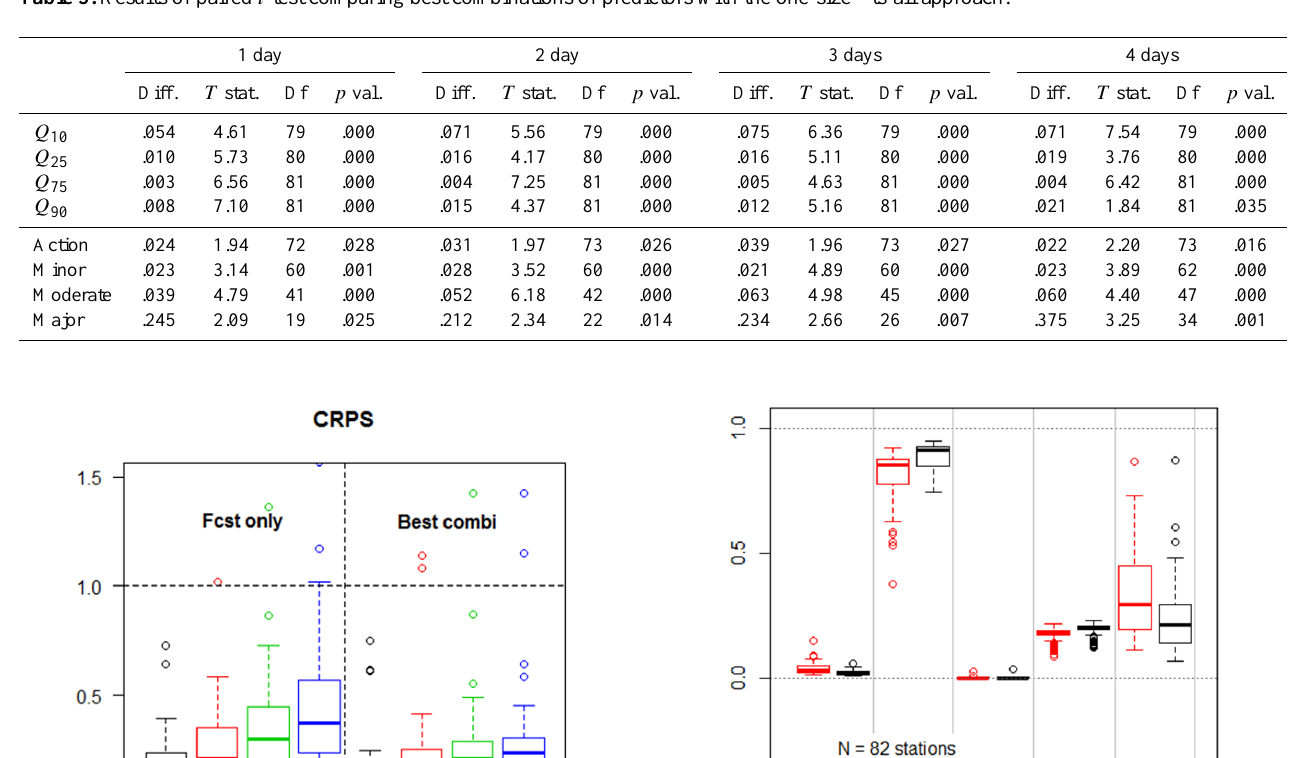
Table 5. Results of paired t test comparing best combinations of predictors with the one-size-fits-all approach.